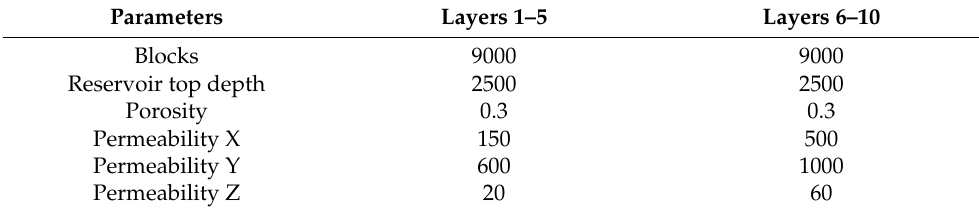
Table 1. Reservoir characteristics of the model.